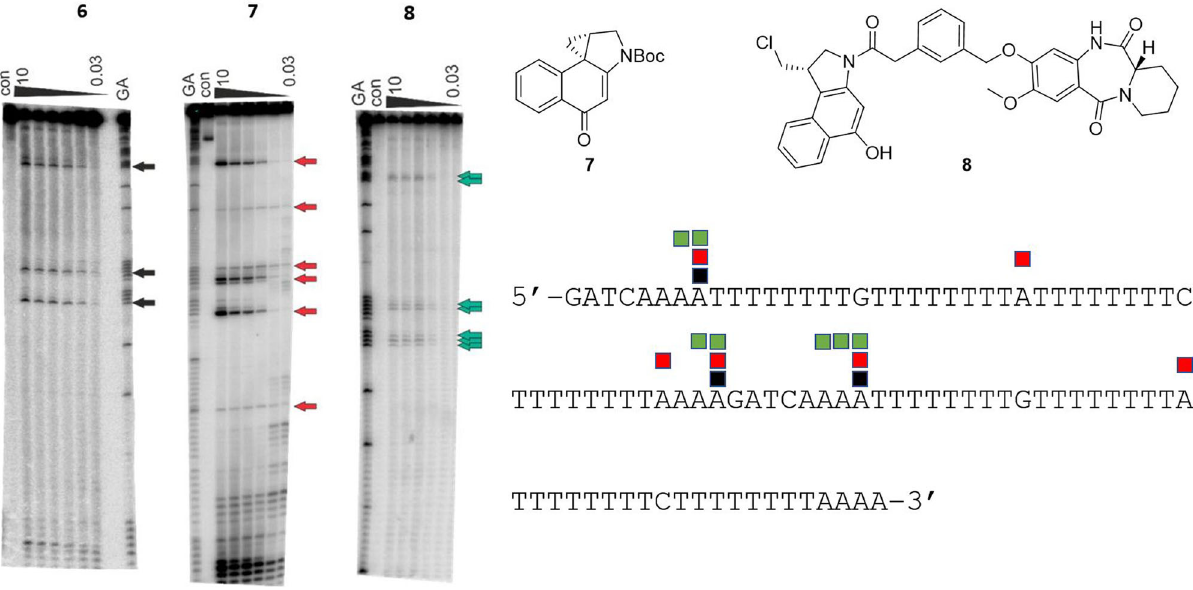
Fig. 5 DNA cleavage assay for the G-A cross-linking agent FGX8-46 (6), and compounds 7 and 8, on the 135 base-pair WnGWn DNA fragment that contains isolated guanines within long tracts of adenines and thymines. The WnGWn was incubated with 10, 3, 1, 0.3, 0.1 and 0.3 μ M of 6 , 7 and 8 (indicated at tops of gels) in 10 mM Tris-HCl, 10 mM NaCl at pH 7.5 overnight at 37 °C, and a dose-dependent effect is evident (Left). The ‘ GA ’ lanes contain Maxam-Gilbert markers speci fi c for purines, and the ‘ con ’ lanes are controls in the absence of 6 , 7 and 8 . The black, red and green arrows on the gels show the locations of cleavage points due to the CBI component of the compounds, thus indicating covalent binding sites. These cleavage sites are also indicated on the DNA sequence using coloured blocks (Bottom